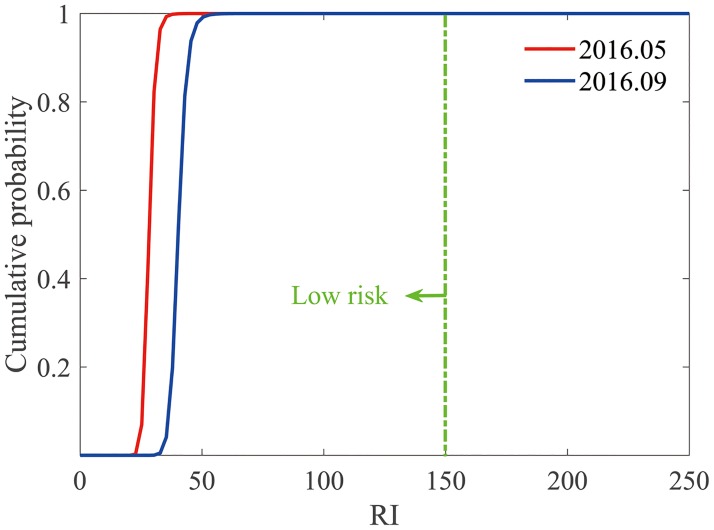
Cumulative probability curves of RI of the seven heavy metals in the surface sediments of western Laizhou Bay.RI is the ecological risk for the sediment, and the green dotted line represents RI = 150. Cumulative probability curves of RI on the left side of this straight line indicate low risk.